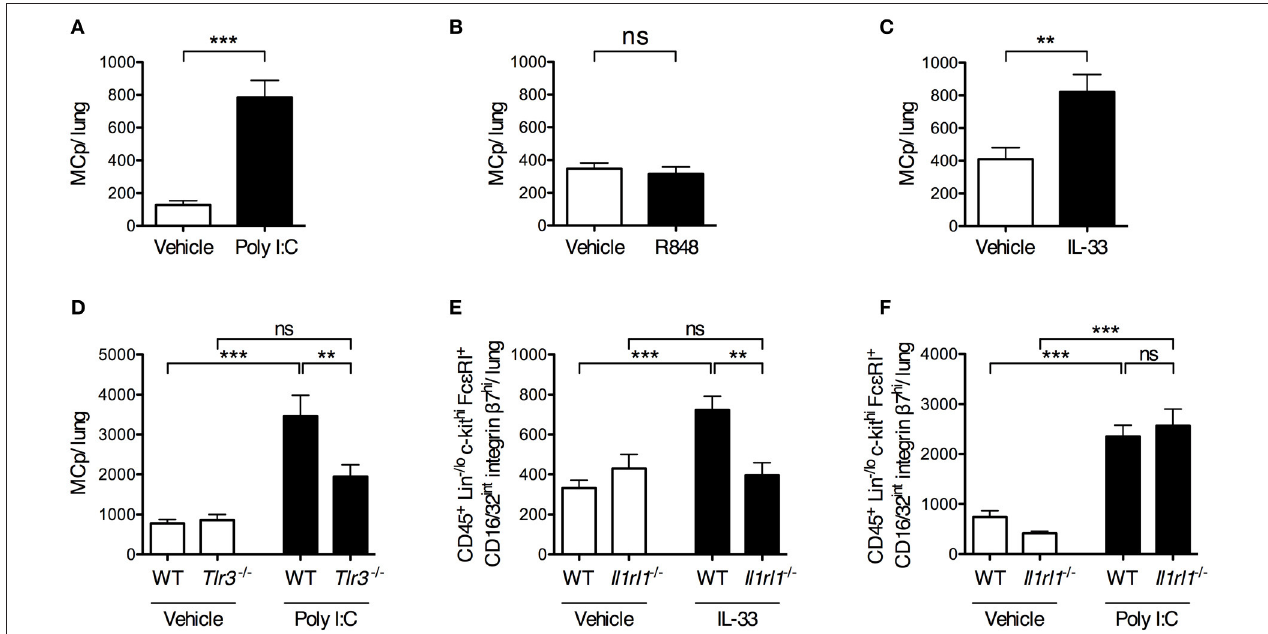
FIGURE 3 | Intranasal administration of Poly I:C or IL-33 increases the number of lung MCp in a TLR3- or ST2-dependent manner. (A,B) The total number of MCp per mouse lung 24h after the mice received vehicle or Poly I:C (A) or R848 (B) i.n. for 4 consecutive days. The data in (A) are pooled from three independent experiments ( n = 8–12) and the data in (B) from two independent experiments ( n = 9). (C) The total number of MCp per mouse lung 24h after the mice received IL-33 or vehicle i.n. for three consecutive days. The data are pooled from four independent experiments ( n = 14–16). The data in (A–C) were analyzed by unpaired, two-tailed Student’s t -test. (D) The total number of MCp per mouse lung in wild type (WT) and Tlr3 − / − mice given Poly I:C or vehicle. The data are pooled from three independent experiments ( n = 10). (E) The total number of CD45 + Lin − / lo c-kit hi Fc ε RI + CD16/32 int integrin β 7 hi cells per mouse lung gated as shown in Supplementary Figure 4 . The data are pooled from three independent experiments ( n = 8–12). (F) The total number of CD45 + Lin − / lo c-kit hi Fc ε RI + CD16/32 int integrin β 7 hi cells per mouse lung. The data are pooled from two independent experiments ( n = 7–8). The data in (D–F) were analyzed by one-way ANOVA with Tukey’s multiple comparisons test. All data are expressed as mean ± SEM. no significant